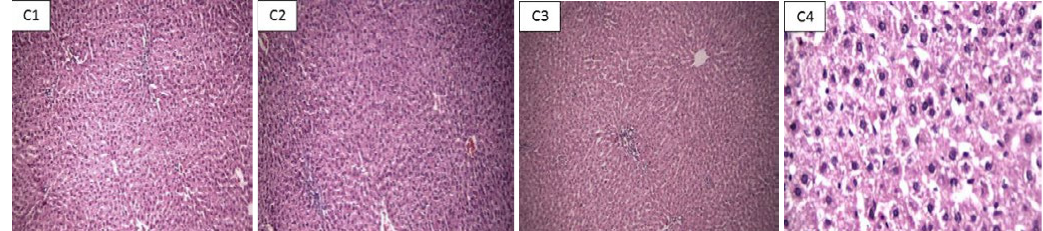
Fig. 4. Photomicrographs of liver sections obtained from rats exposed to different concentrations of IONs. (C2, C3, C4) control rats received 50, 500, 5000 mg/kg of IONs, respectively (C1, C2, C3): normal liver, C4: hepatic degeneration in liver (Staining with hematoxylin and eosin). Magnification: 40 x for panels.